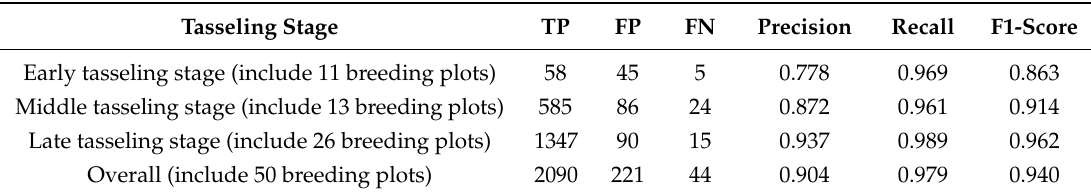
Table 3. Evaluation of tassels detection